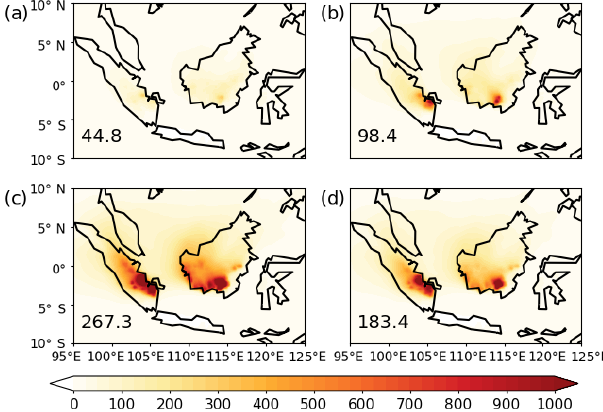
Figure 7. Mean simulated surface PM 2 . 5 concentration (µgm − 3 ) from fires for September–October 2015 with the surface injection and (a) FINN emissions, (b) FINN+GFEDpeat, (c) FINNpeat and (d) FINNpeatSM. The surface PM 2 . 5 concentration from fires, av- eraged over Borneo and Sumatra, is indicated on each panel.